Question: Briefly state, in one sentence, what is plotted here.
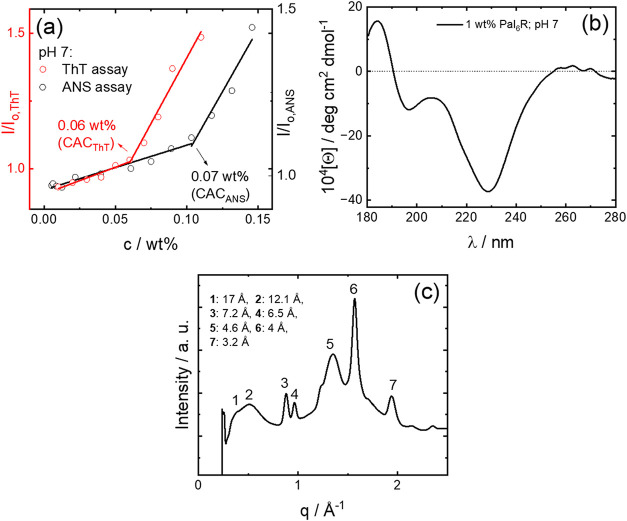
Answer: Aggregation and conformation of Pal 6 R at pH 7. (a) Determination of critical aggregation concentration (CAC) from the intensity of the ANS (ThT) peak fluorescence I ANS ( I ThT ) relative to that of the solution without peptide I 0,ANS ( I 0,ThT ). (b) Circular dichroism spectrum at conditions indicated. (c) XRD spectra stalk dried from a 2 wt % solution of Pal 6 R at pH 7.